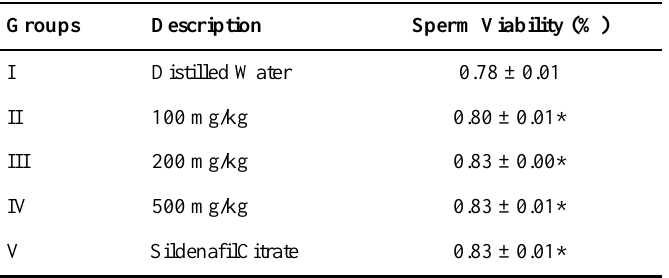
Table 1.3: Effect of MPAE on Sperm viability of the male rats.